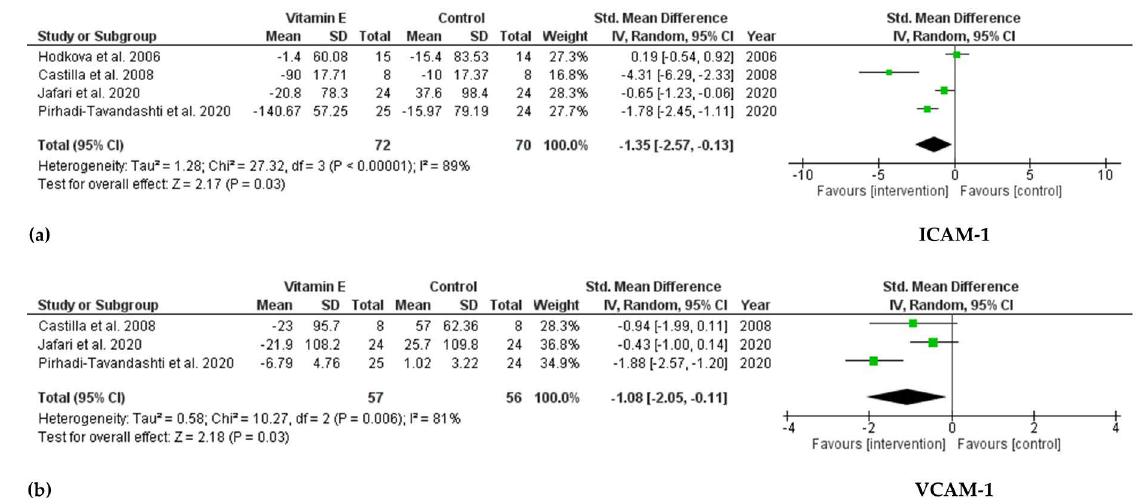
Figure 3. Forest plot for effect of vitamin E supplementation on ( a ) ICAM-1 and ( b ) VCAM-1 in hemodialysis patients.